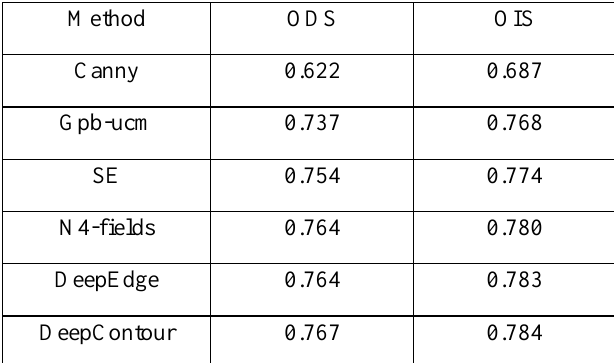
Table 1. Comparison between proposed model